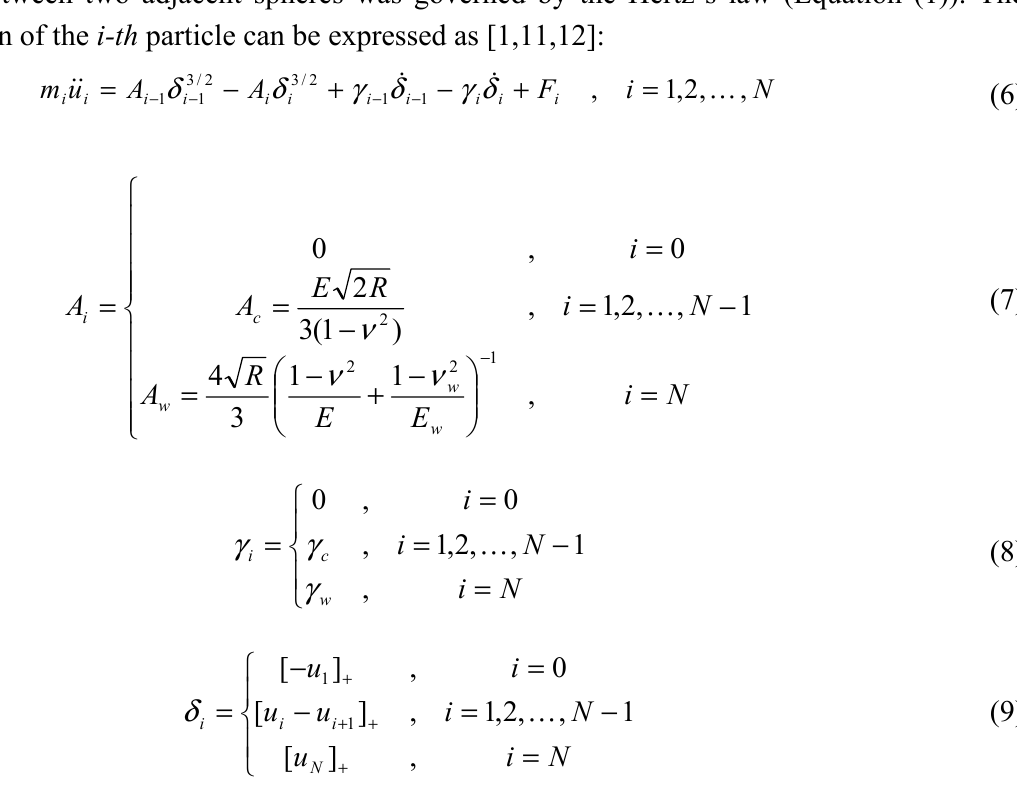
Figure 3. Schematic diagram of the one-dimensional discrete element model. The c 1 , c 2 ,…, c N indicates the points of contact between two neighboring particles. When the presence of the piezo rod is modeled, the spheres 13 and 18 are replaced by solid